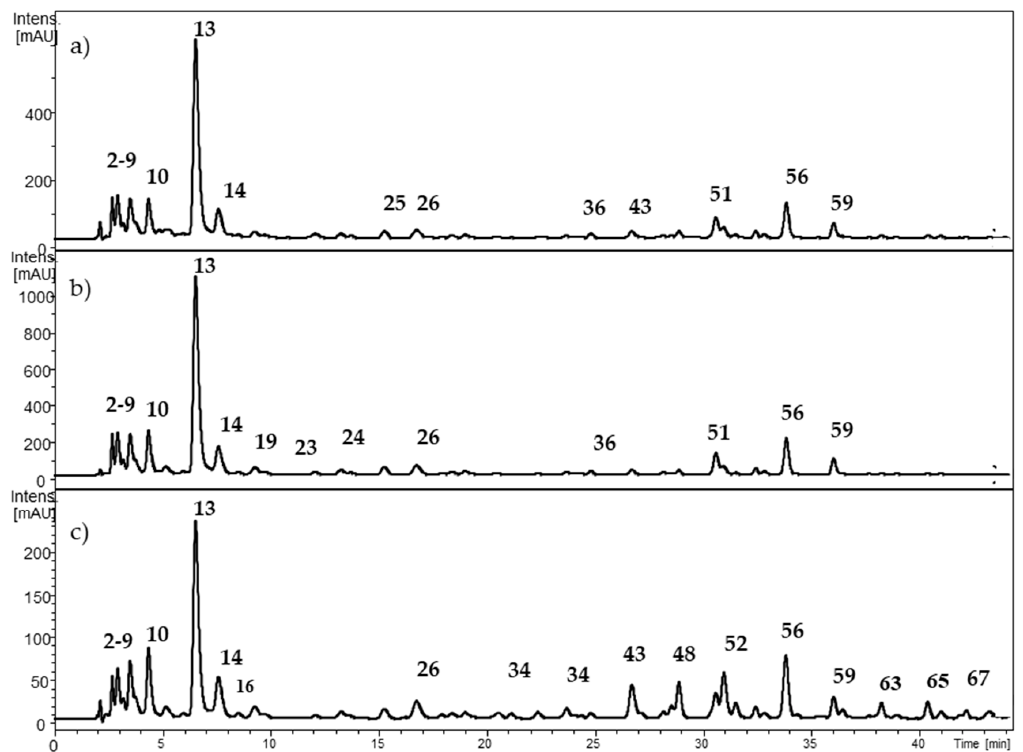
Figure 3. HPLC-DAD chromatogram from Berberis microphylla at ( a ) 280 nm; ( b ) 320 nm; and ( c ) 360 nm. The numbers correspond to Table 3.